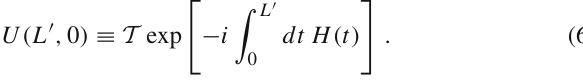
Fig. 1 Overview of the quantum circuit detailed in the main text. Sin- gle lines denote quantum channels while double lines denote classical ones. Above each line we detail the state being store in the circuit (see